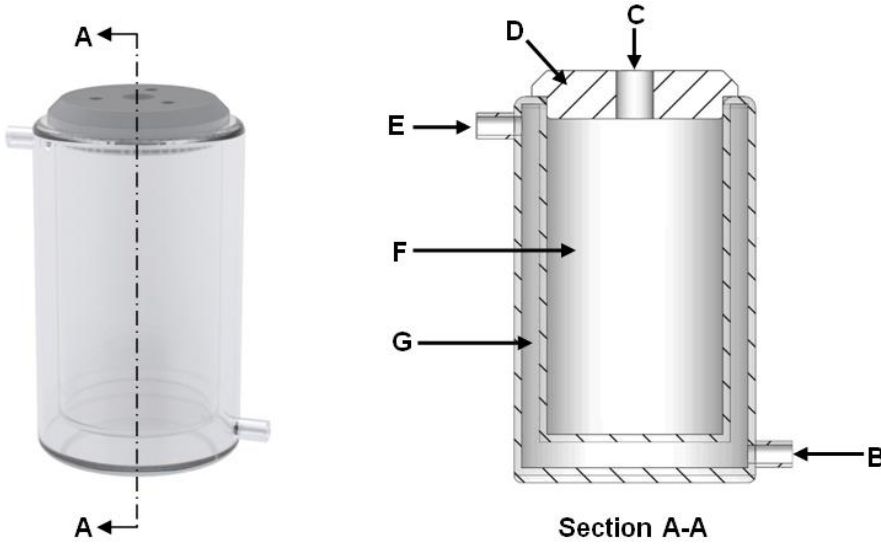
Figure 5. Double walled glass reactor used during the aging step. (A-A) Section cutout view; (B) Hot water inlet; (C) Cutout in reactor lid allowing the impeller shaft to pass through; (D) Reactor lid; (E) Hot water outlet; (F) Reaction volume; (G) Heating/cooling water space surrounding the inner reactor